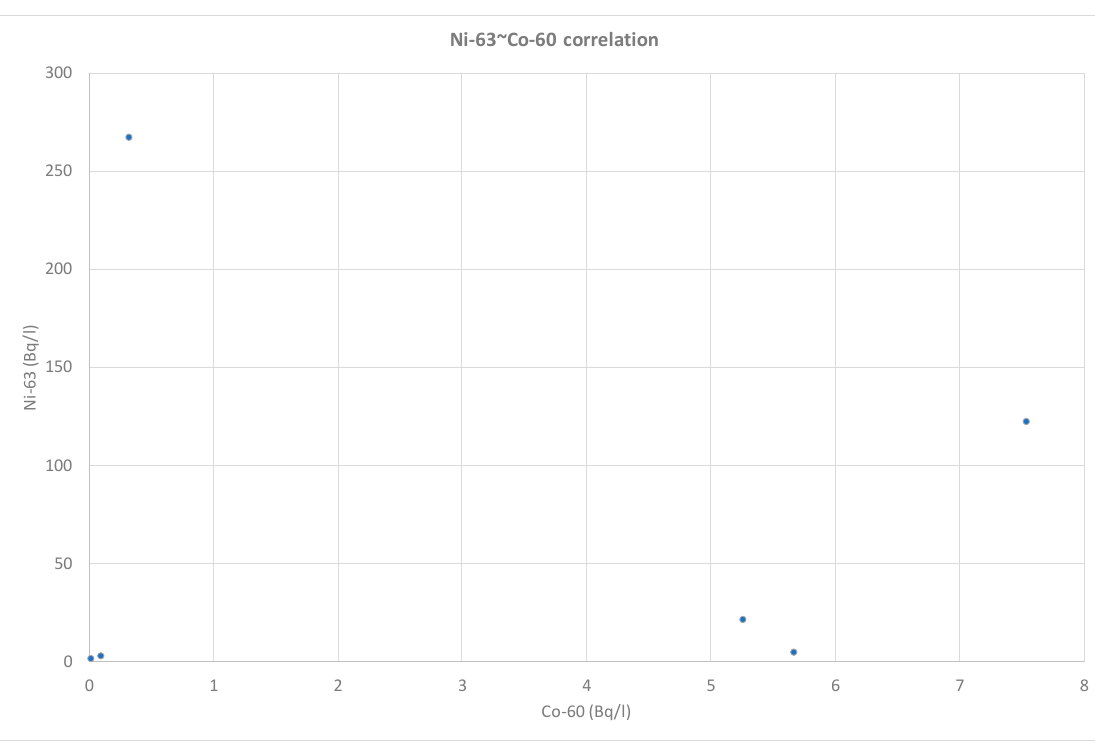
Figure 6. Ni-63~Co-60 correlation present in the Trino “E. Fermi” clearable materials.